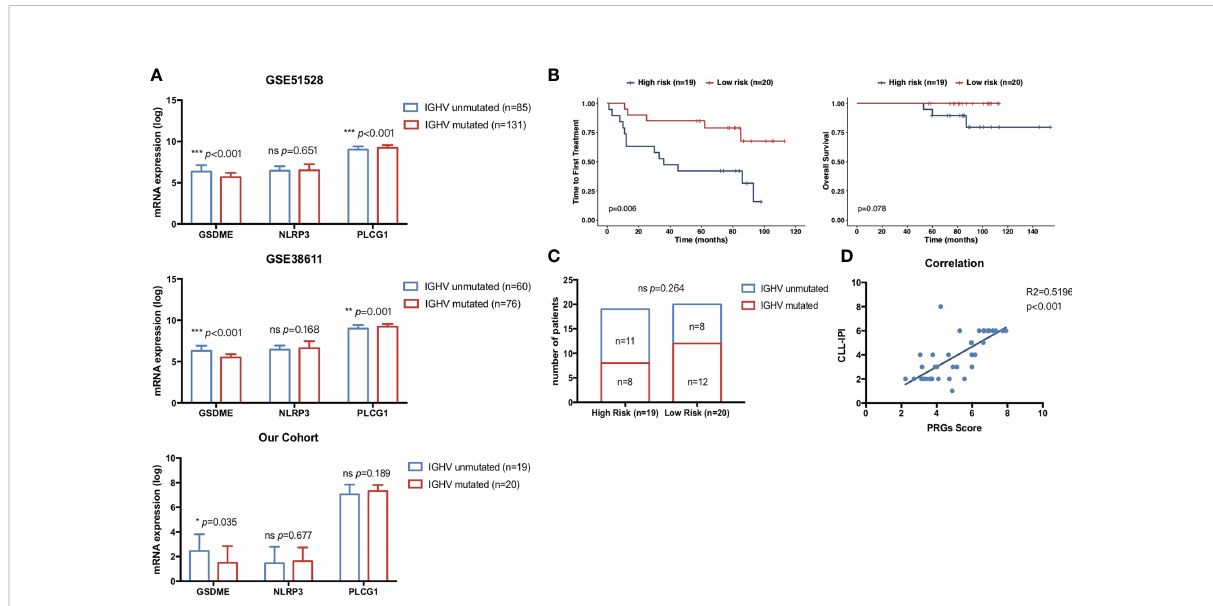
FIGURE 8 Correlation of pyroptosis-related gene expression with clinical prognostic biomarkers. (A) Comparison of the prognostic pyroptosis-related gene expression between 76 mutated CLL and 60 unmutated CLL samples in GSE38611. Comparison of the prognostic pyroptosis-related gene expression between 131 mutated CLL and 85 unmutated CLL samples in GSE6244. Comparison of the prognostic pyroptosis-related gene expression between 20 mutated CLL and 19 unmutated CLL samples in treatment-naïve CLL patients from our center. (B) Kaplan – Meier plot showed OS and TTFT of 39 treatment-naïve CLL patients in our center between high-risk ( n = 19) and low-risk ( n = 20) subgroups divided by PRG scores. (C) Distribution of IGHV status between high-risk ( n = 19) and low-risk ( n = 20) subgroups divided by PRG scores. (D) Correlation of risk scores in the pyroptosis-related gene model and CLL-IPI. p -values were shown as * p < 0.05; ** p < 0.01; *** p <